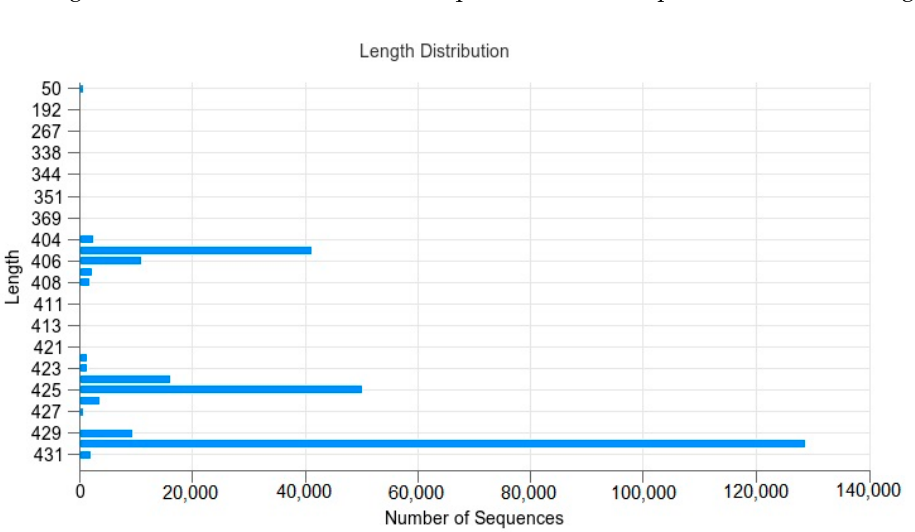
Figure 1. Sequence–length distribution: The abscissa is the number of sequences, and the ordinate is the length of the